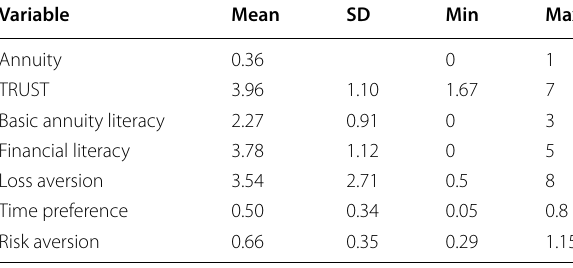
Table 2 Summary statistics